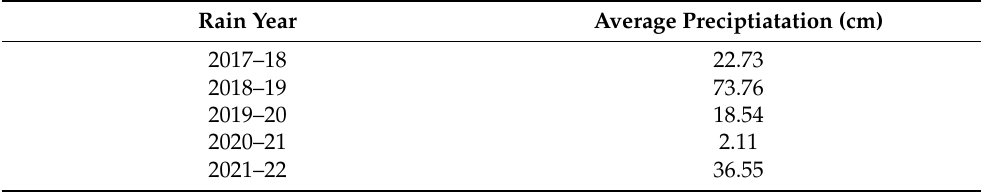
Table A1. Total annual rainfall, calculated using data from the Western Regional Climate